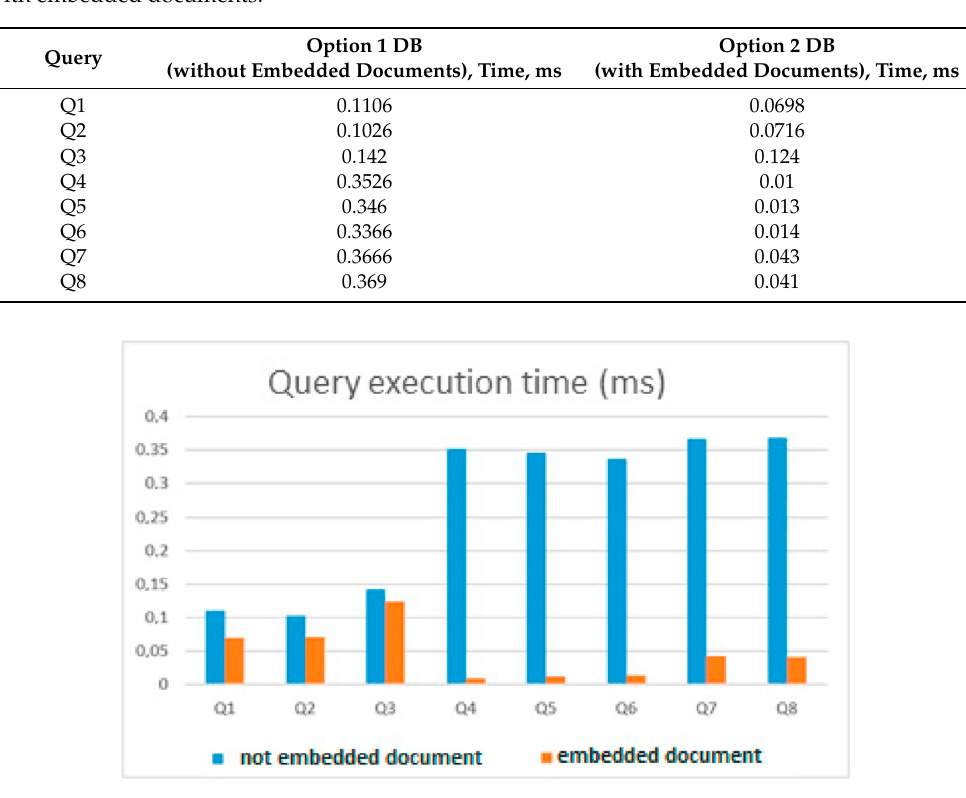
Figure 7. A diagram showing the execution time of eight queries to a database of two types: a single database and a database with embedded